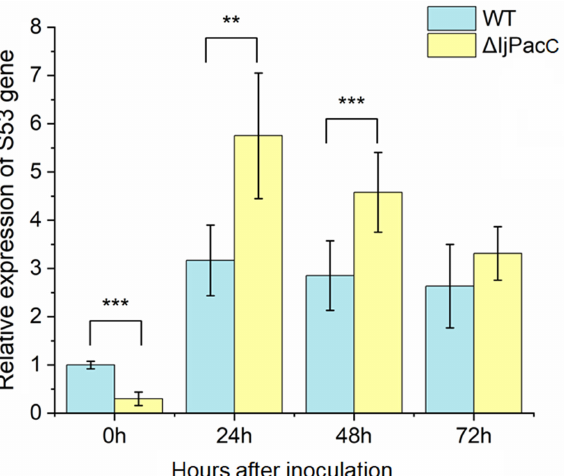
Figure 5. Expression dynamics of a S53 gene (IF1G_06234) in the Δ IjpacC mutant and WT strains of I. javanica during the fungal infection on caterpillars. Error bar represents the standard error of the mean. Asterisk marker represents significant difference at a statistical level, (**) p < 0.01, (***) p < 0.001.